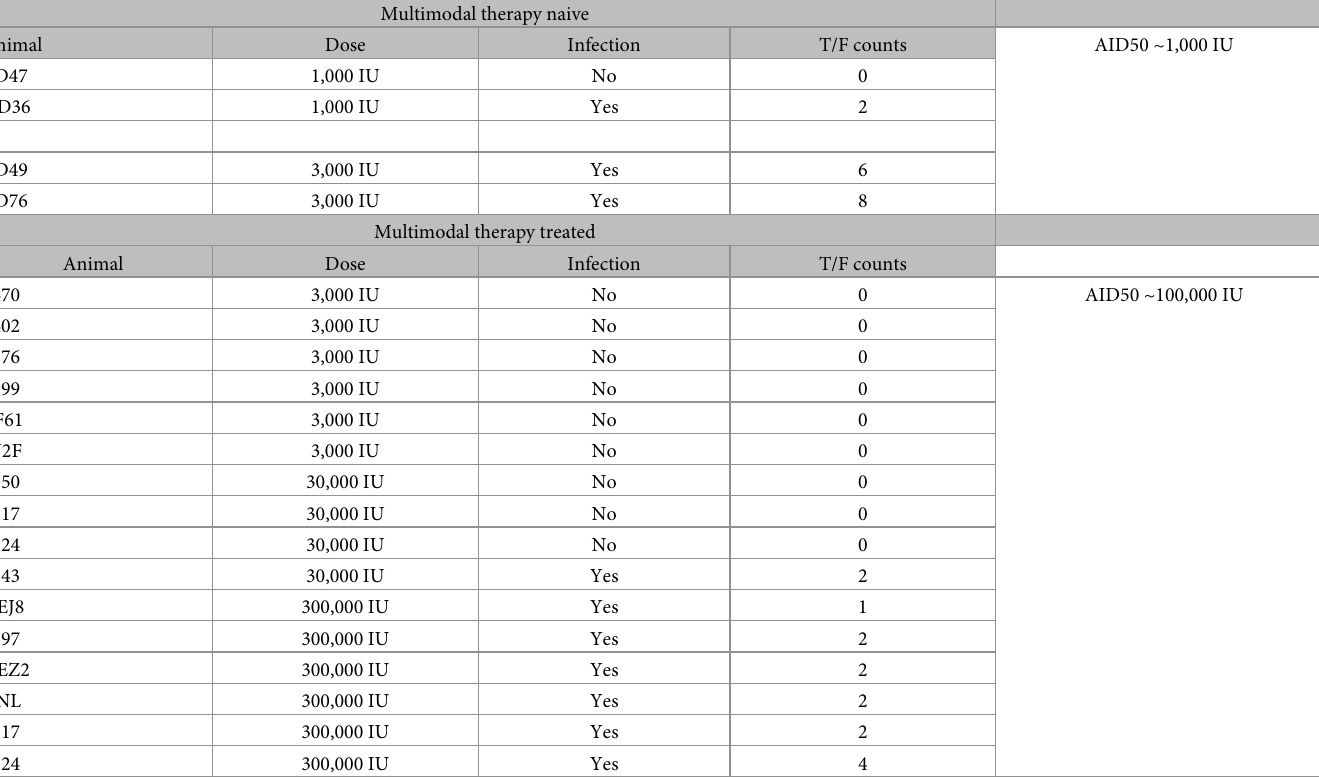
Table 1. Evaluation of acquisition of intrarectal challenged SIVmac239X and enumeration of transmitted/found variants in multimodal treated and untreated rhe- sus macaques.